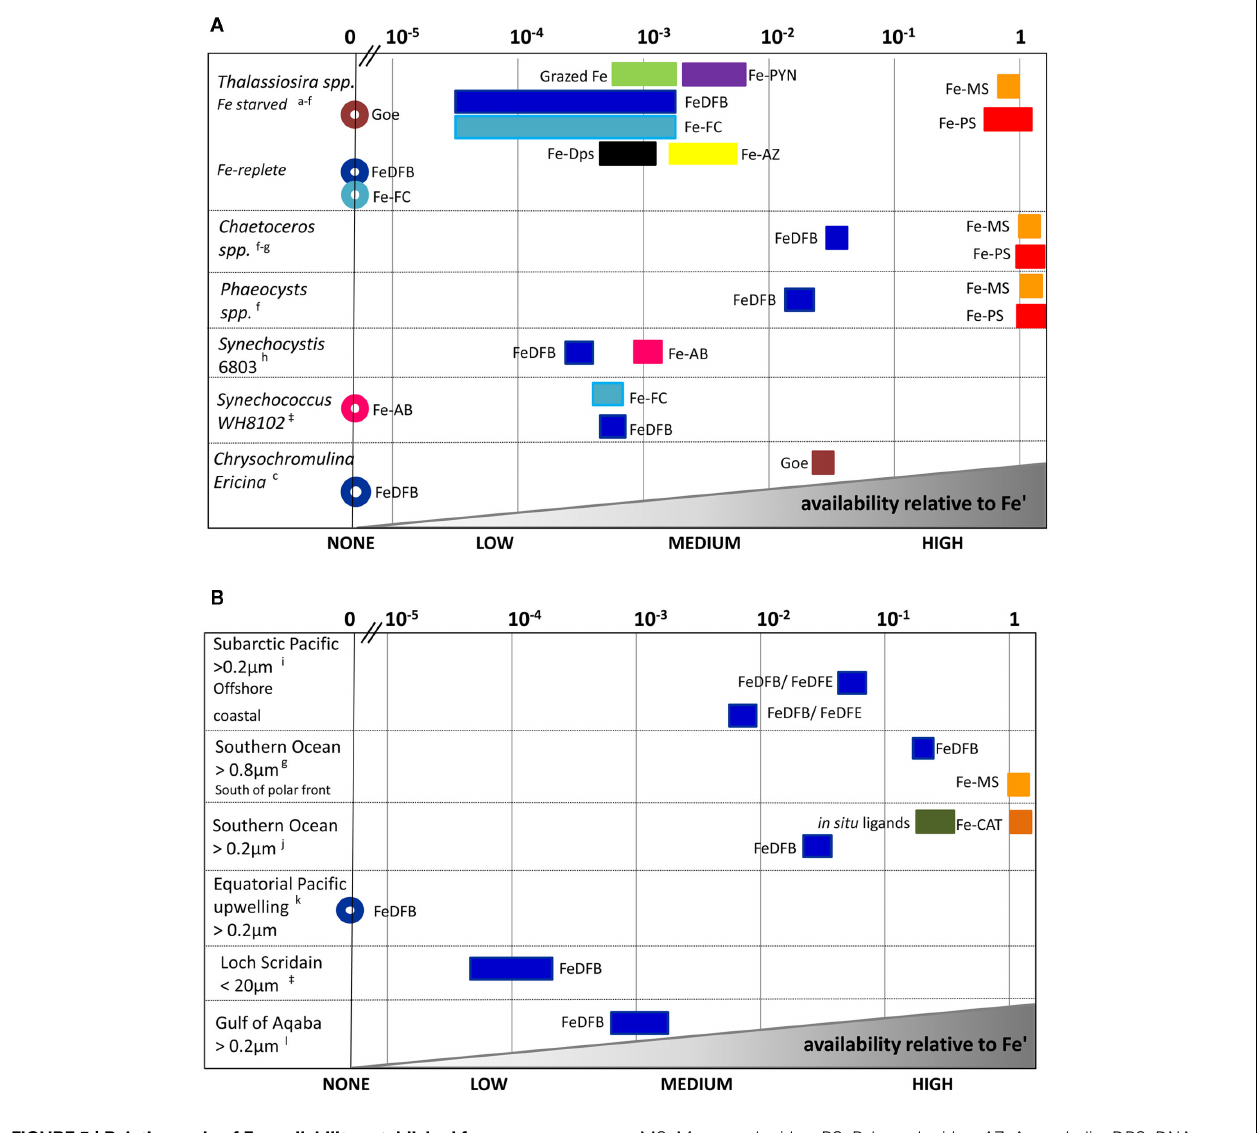
FIGURE 5 | Relative scale of Fe availability established from phytoplankton uptake rates obtained for cultures (A) and natural assemblages (B). By converting experimental data to uptake-rate constants, and normalizing it further relative to Fe’, comparisons across organisms, Fe-substrates and environments are made possible (see text and Figure 4 for details). Different Fe-complexes are presented as different colors, while bar length represents variations among experiments, and circles denote no uptake. Abbreviations: Goe, goethite; DFB, desferrioxamine B; AB, Aerobactin; FC, ferrichrome; PYN, Porphyrin;